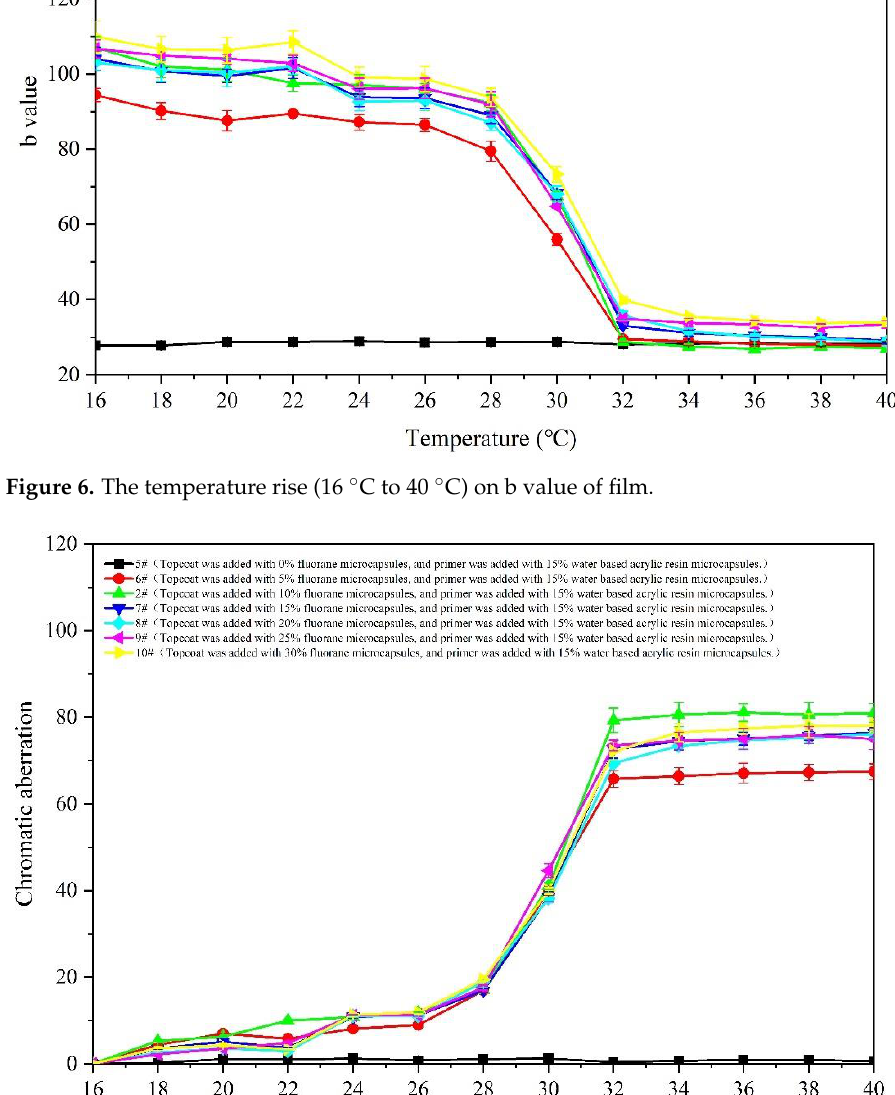
Figure 8. The influence of cooling on color difference of coating. The decreasing trend of the film gloss with the additional amount of fluorane mi- crocapsules is shown in Table 6 and Figure 9. The gloss of 5# coating is higher than that of 6 – 11# coatings with different contents of fluorane microcapsules added to other topcoats. This may be due to the fact that 5# topcoat does not contain fluorane microcapsules. The primer is added with 15% waterborne acrylic resin microcapsules, and the surface of the topcoat is smoother, so the gloss is relatively high. From the overall trend, the gloss of the film decreases gradually with the increase in fluorane microcapsule content in the top- coat. The reason may be that the roughness of the coating surface increases with the in-